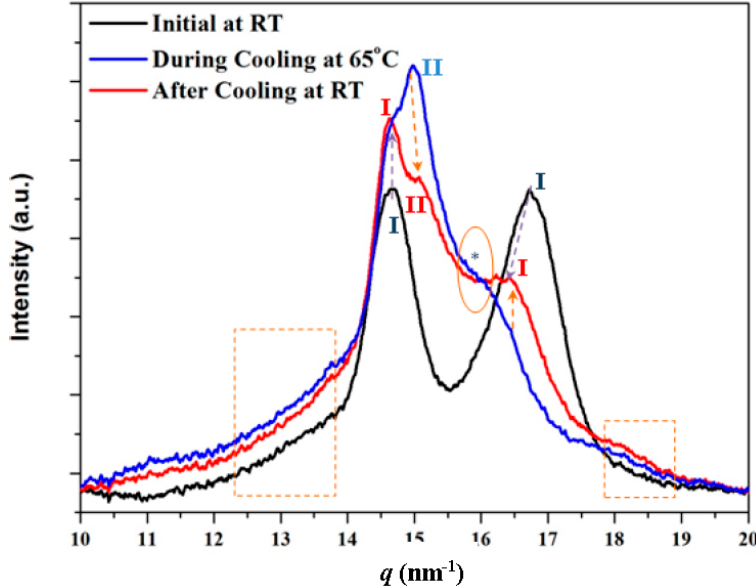
Figure 9. Diffraction profiles taken at room temperature for the solution (black) and melt (red) crystallized samples. Purple arrows compare the peaks associated with Form I. For the sake of completeness, a profile taken during cooling at 65 °C (blue) is also given. Evolution during cooling of some Form I and Form II representative peaks is indicated by the orange arrows and the shoulder associated with Form II with the asterisk and the ellipsoid. Dashed rectangles indicate the regions where tails of the amorphous halo could be detected.